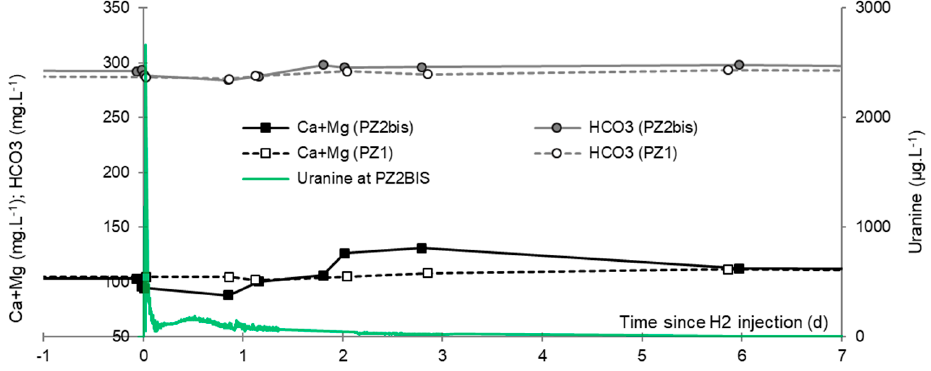
Figure 22. Comparative evolution of the concentrations of dominant ions and tracer at PZ1 (20 m upstream) and PZ2BIS (5 m downstream) during the week following the injection of dissolved hydrogen.